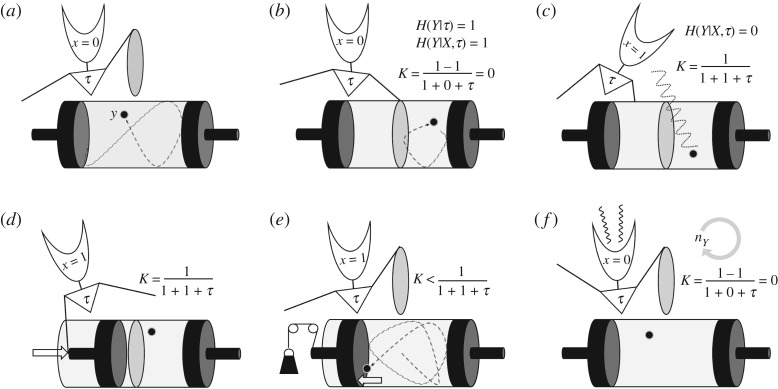
Illustration of Maxwell’s ‘pressure demon’ paradox, and how it relates to K. (a) The system is set up, described by τ, with a default memory state X = 0. (b) A partition is placed in the cylinder, generating one bit of information in the explanandum Y. The demon has zero knowledge about the molecule’s position. (c) A measurement is made, allowing the position of the molecule to be stored in memory. An amount K of knowledge is now possessed by the demon and put to use. (d) One of the pistons is pushed down allowing work to be extracted from the system. (e) Work is extracted at the expense of the demon’s knowledge. (f) The demon’s knowledge is now zero and its memory is re-set, dissipating entropy in the environment. The cycle will be repeated nY times. See text for further explanations.